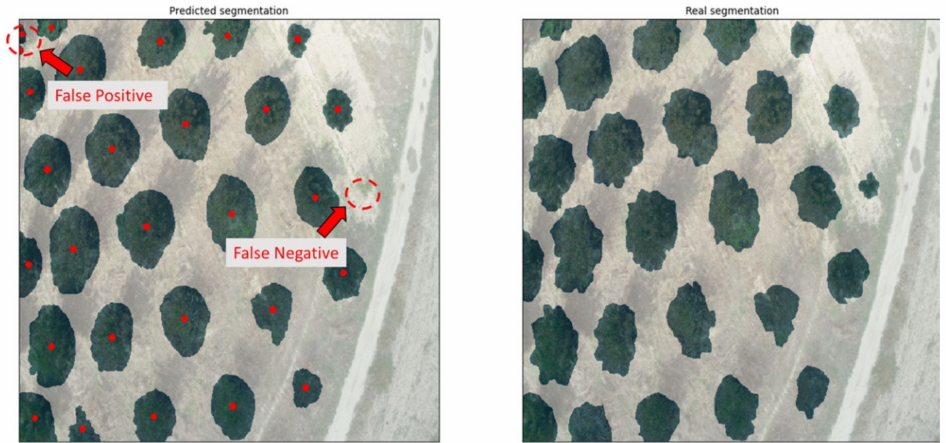
Figure 6. Examples of false positive and false negative segmentation predicted by the developed system ( left ) as compared to the real segmentation ( right